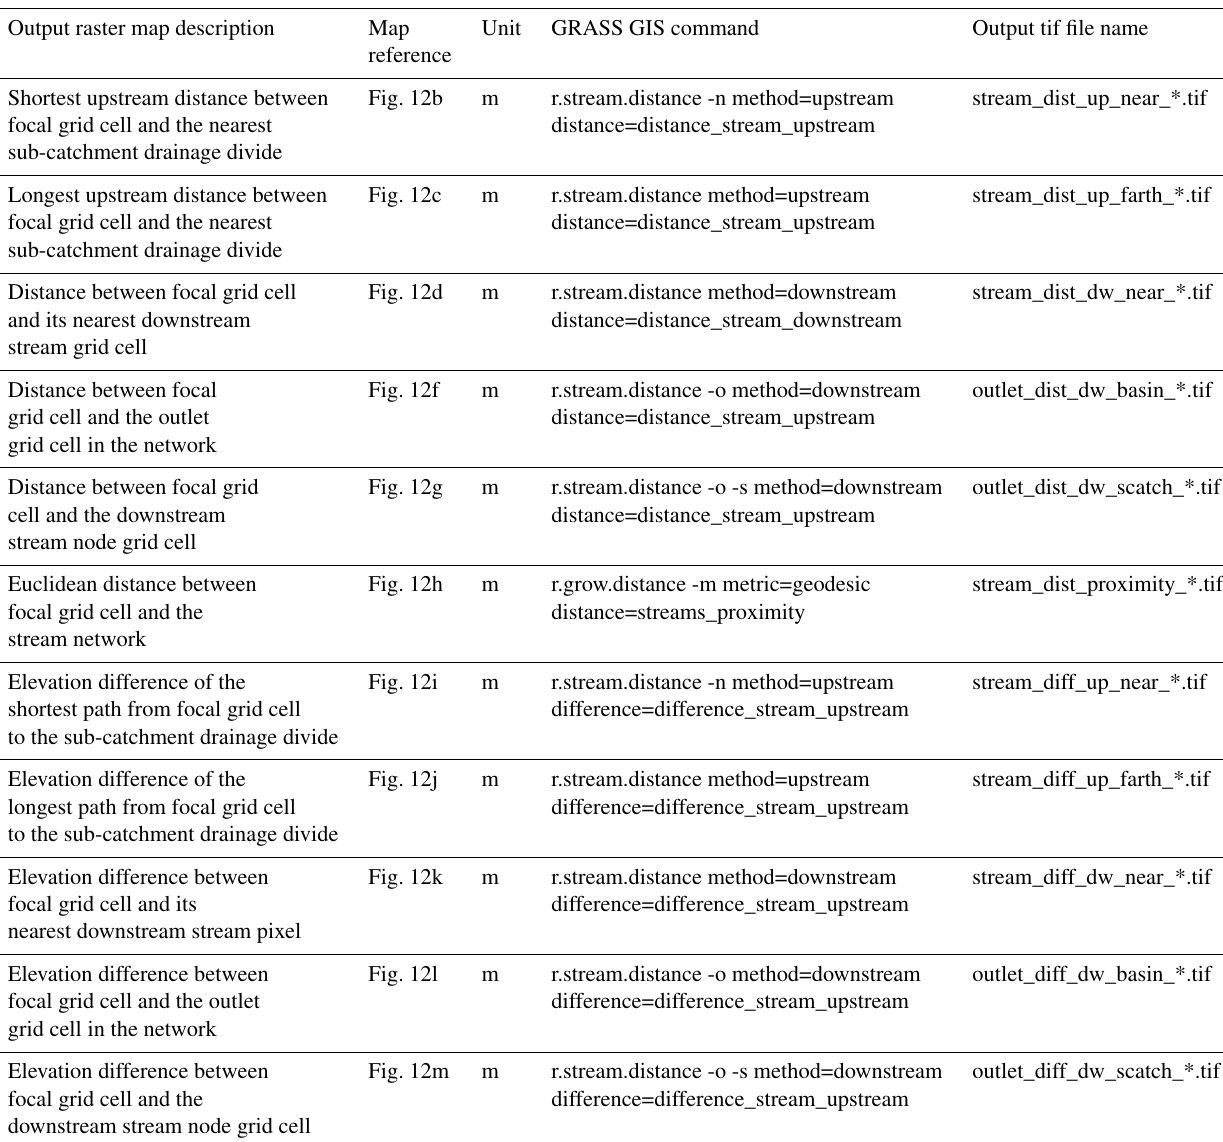
Table 4. Stream or outlet distance and elevation difference raster maps computed with the r.stream.distance GRASS GIS module; map reference corresponding to Fig. 12; unit; GRASS GIS command; and output layer